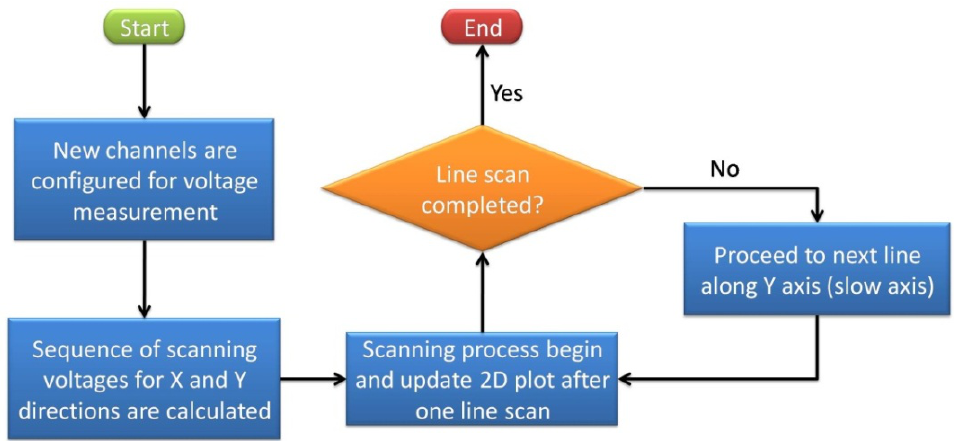
Figure 6. Flowchart of scanning process. There are three major sections in the software. First, the input and output channels are configured for measurement. Second, the sequence of scanning voltages is generated. Finally, the actual scanning process begins and the 2D plot is updated after every line scan.